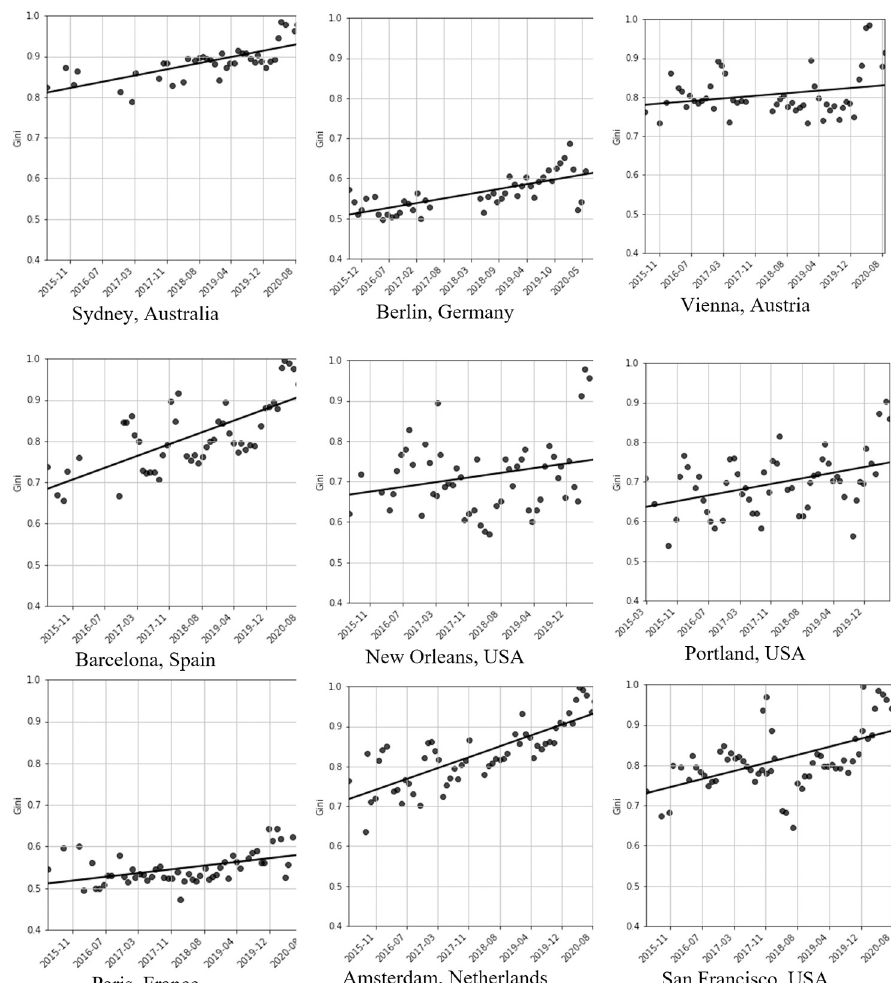
Fig 3. The evolution of the Gini coefficient measured for the nine cities for which data is available since 2015. A OLS tendency line is included to show the evolution of the